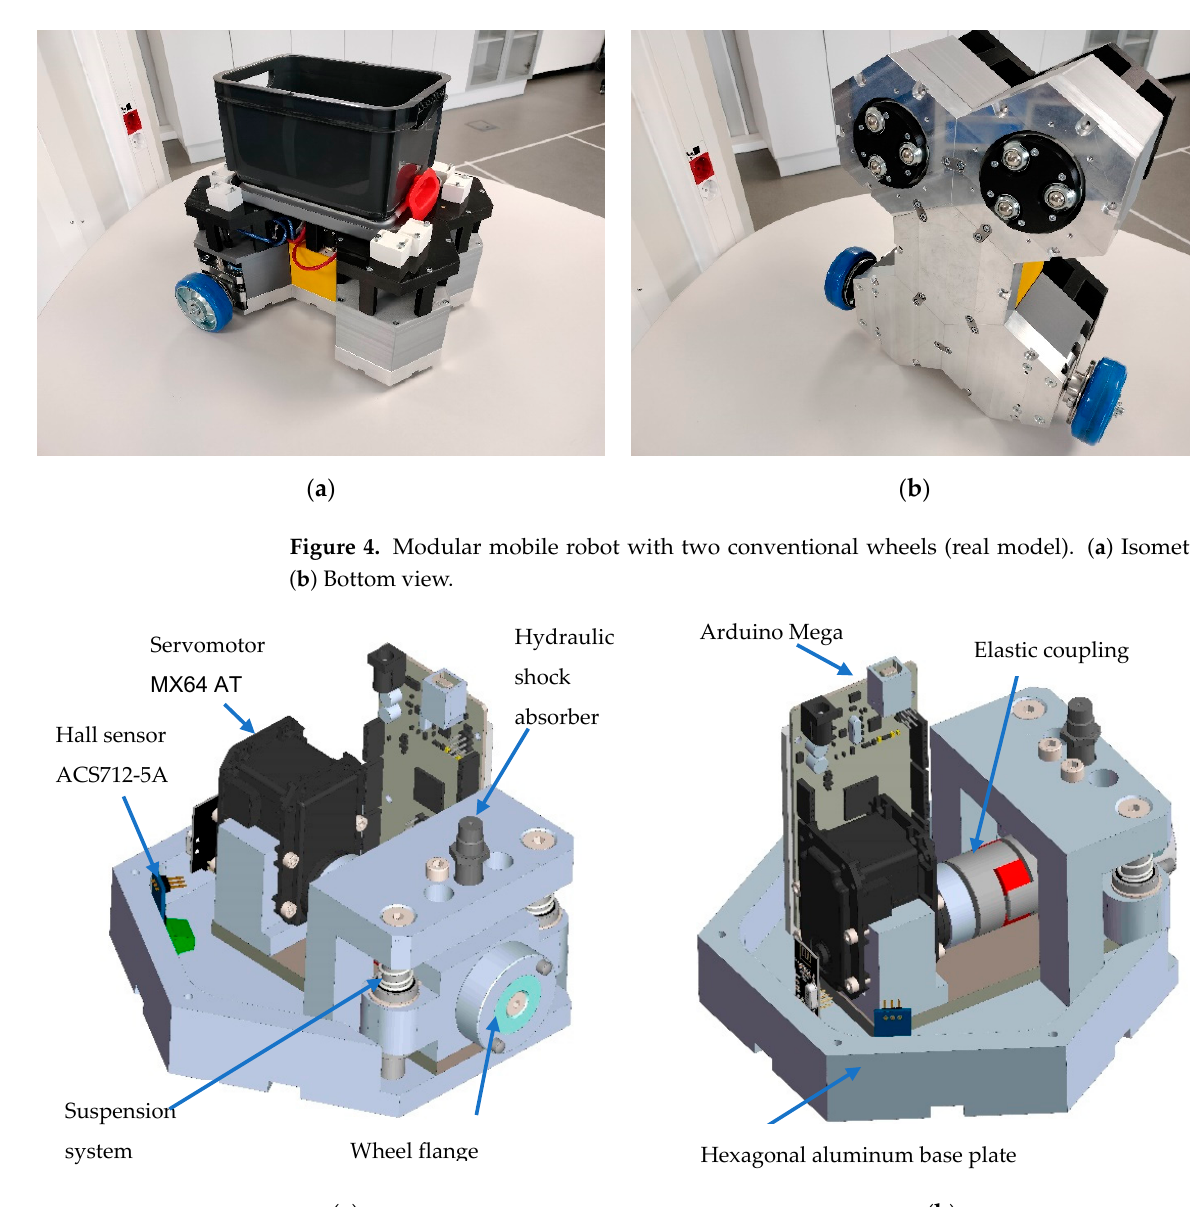
Figure 5. Drive wheel module of the modular mobile robot (3D model). ( a ) External view. ( b ) Internal view.